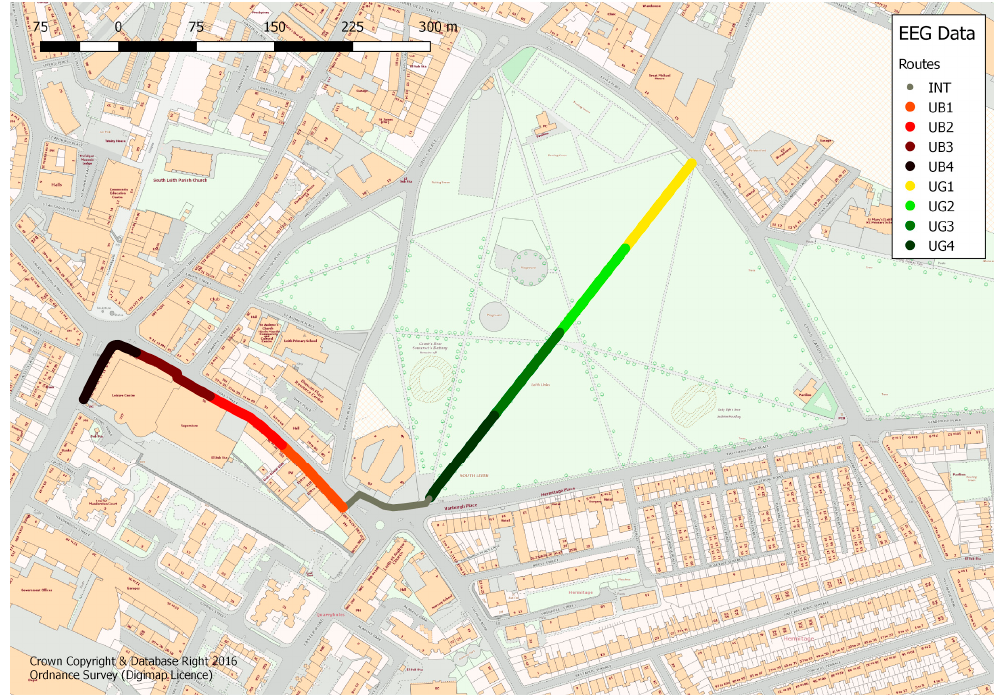
Figure 2. Map of the walking route undertaken by participants (walking in one of the two possible directions). Note: UG = Urban green (green space); UB = Urban busy (streetscape); Int = Interchange, the transitional section between these two environments. Table 2. An overview and typology of the quartiles from urban green to urban busy derived from Geographic Information System (GIS).